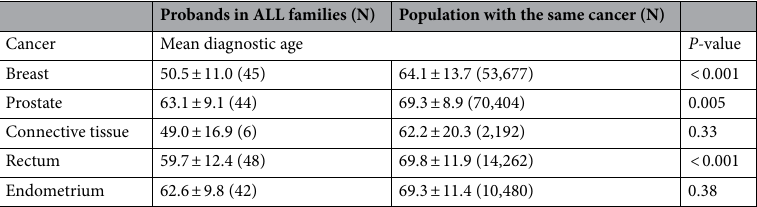
Probands in ALL families (N) Population with the same cancer